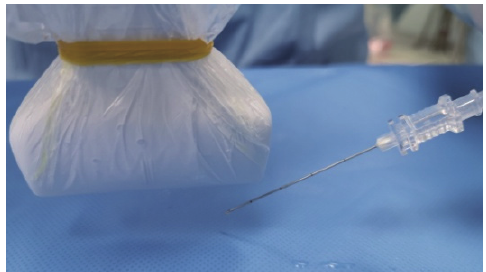
Figure 11 Free-hand